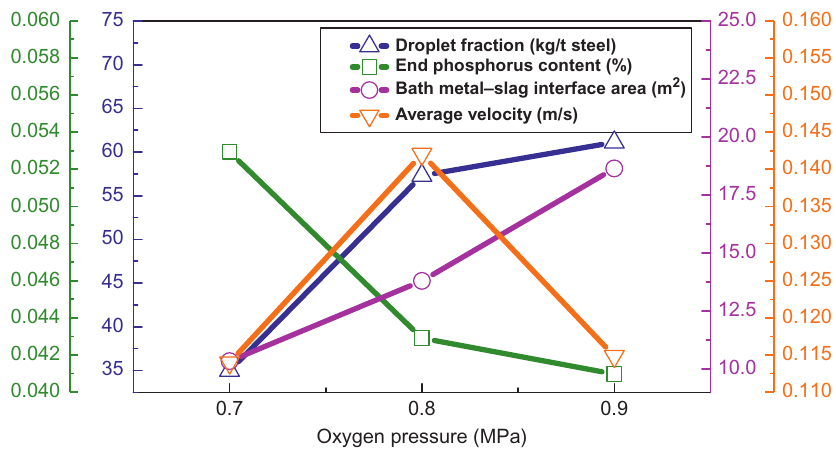
Figure 6: Parameters related to dephosphorization kinetics at different oxygen